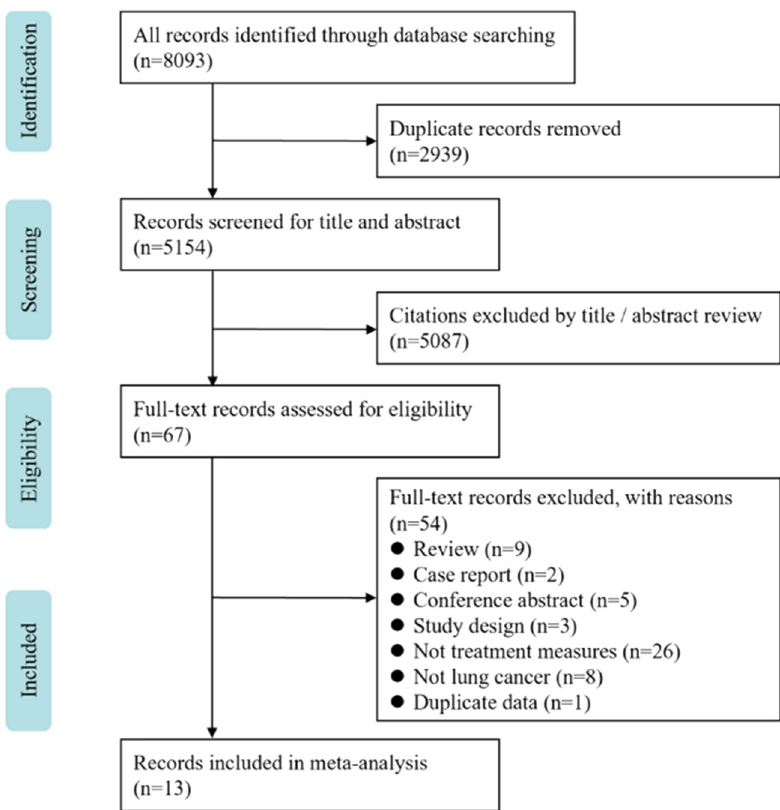
Figure 1: PRISMA fl ow chart for literature